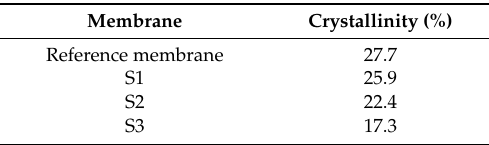
Table 2. Percentage of